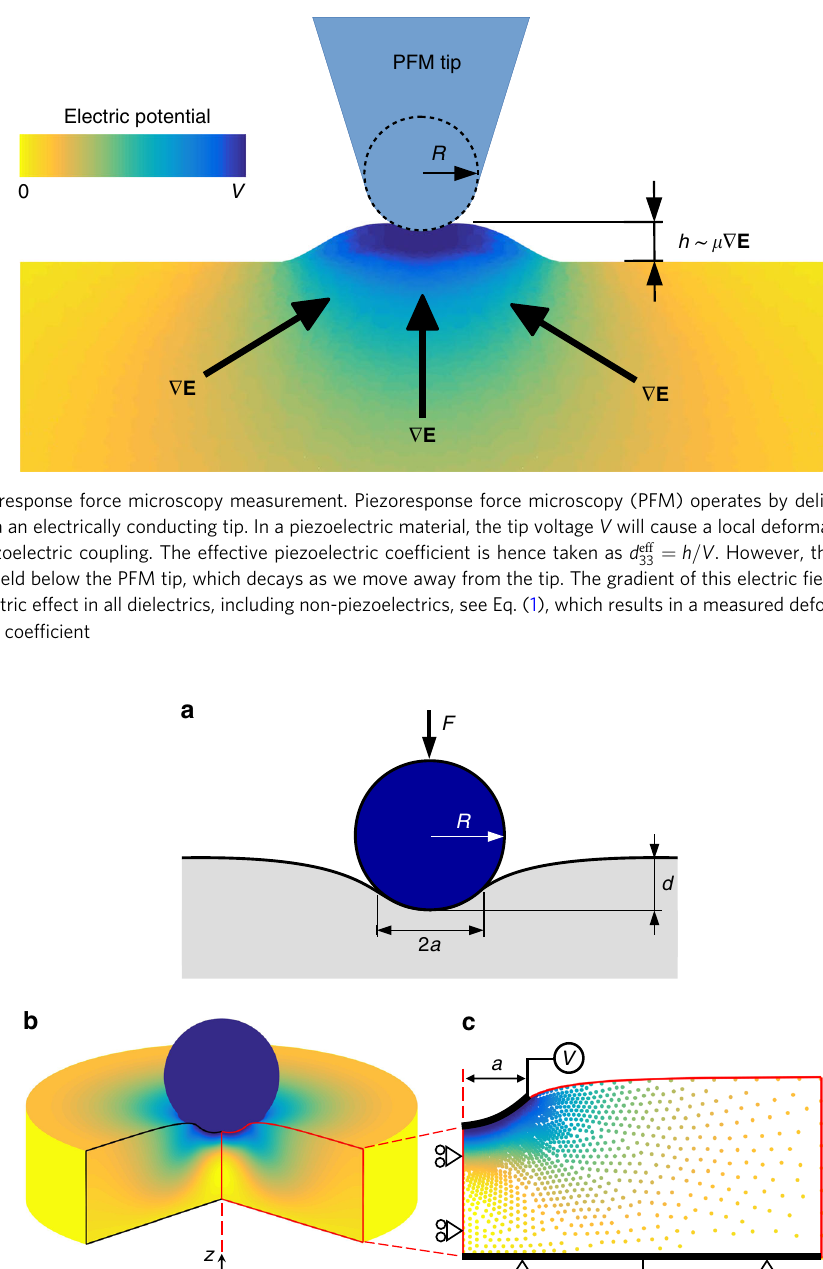
Fig. 2 Contact of a spherical piezoelectric force microscopy tip with a fl at surface. a Schematic of the contact of a spherical tip with radius R under an applied load F which induces an indentation depth of d with contact radius a . b Axisymmetric model of the spherical contact. The rotational symmetry of the spherical tip-sample contact allows us to employ this two-dimensional axisymmetric model in a cylindrical coordinate system ( r , θ , z ). c Computational node set in the deformed con fi guration. The colour plot presents the distribution of the electric potential ϕ . To capture the sharp changes of the strain and electric fi eld in the excited volume, the computational nodes are distributed such that the nodal spacing is gradually diminishes as the contact surface is approached. The electric potential at the nodes in the contact surface (0 ≤ r ≤ a ) is fi xed to the tip voltage V (voltage source symbol). The ground symbol indicates that the nodes on the bottom side of the model are connected to the ground, i.e., the electric potential is fi xed to zero. The roller supports represent the mechanical boundary conditions which imply that the vertical and horizontal displacements are fi xed on the bottom and left sides of the model, respectively The simulation protocol is as follows. We fi rst progressively These qualitative predictions are quantitatively supported by indent until reaching the desired force F at V = 0, and then numerical calculations. In Fig. 3, we show the simulation results the force is kept constant as the tip is electrically biased and the for the effective piezoelectric coef fi cient as a function of contact induced displacement under the tip Δ u z recorded. The effective radius and contact force, calculated for non-piezoelectric SrTiO 3 .